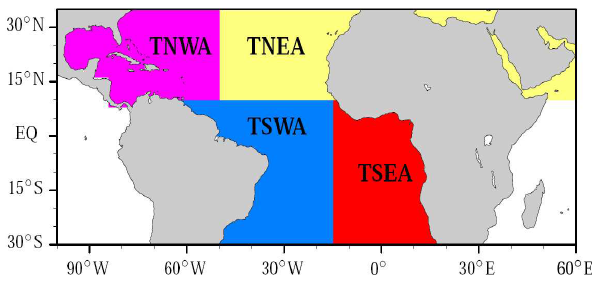
Fig. 1. Choice of different oceanic Fig. 1: Choice of different oceanic regions.